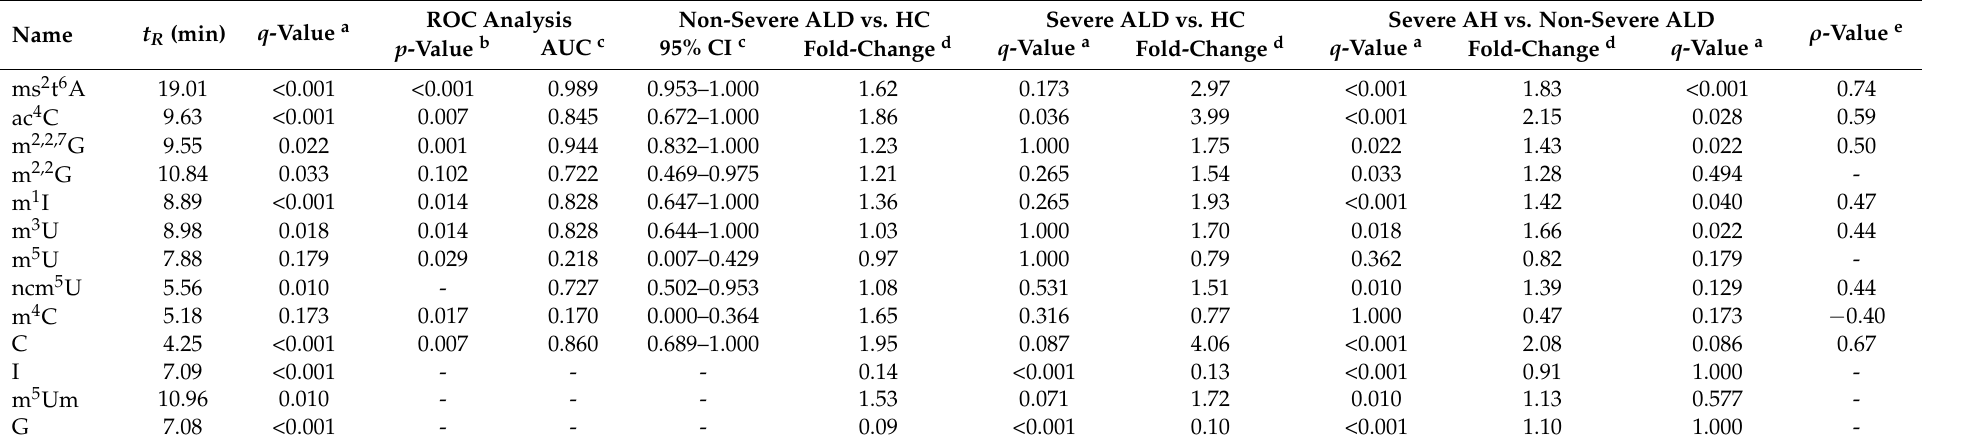
Table 4. Significantly changed ribonucleosides in human serum